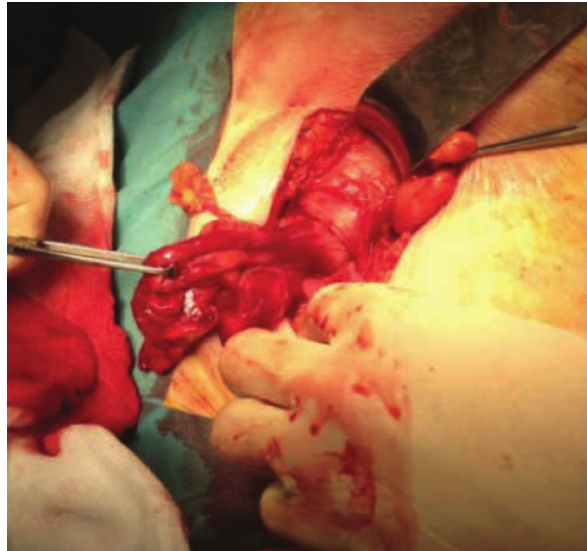
Figure 2: Case Report 1 Inflamed appendix inside the femoral hernia sac.